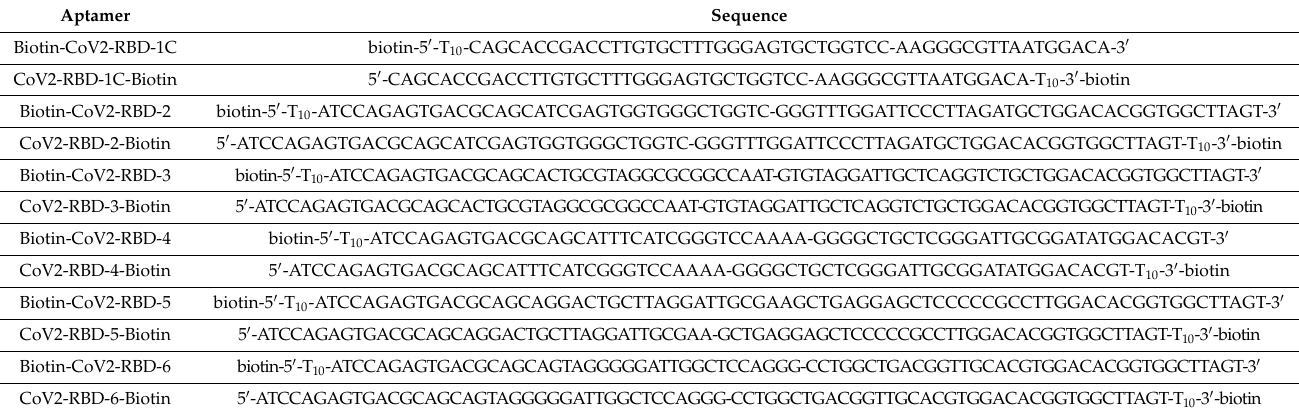
Table 3. Sequences and sites of biotinylating od DNA aptamers studied in this